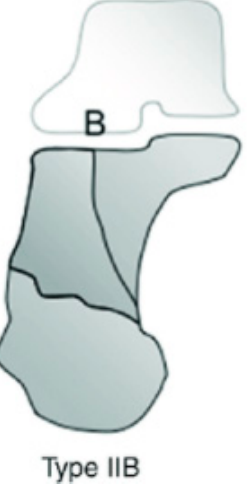
Figure 15. Sanders classification of calcaneal fractures, Type IIB—adapted with permission from Ref. [24].